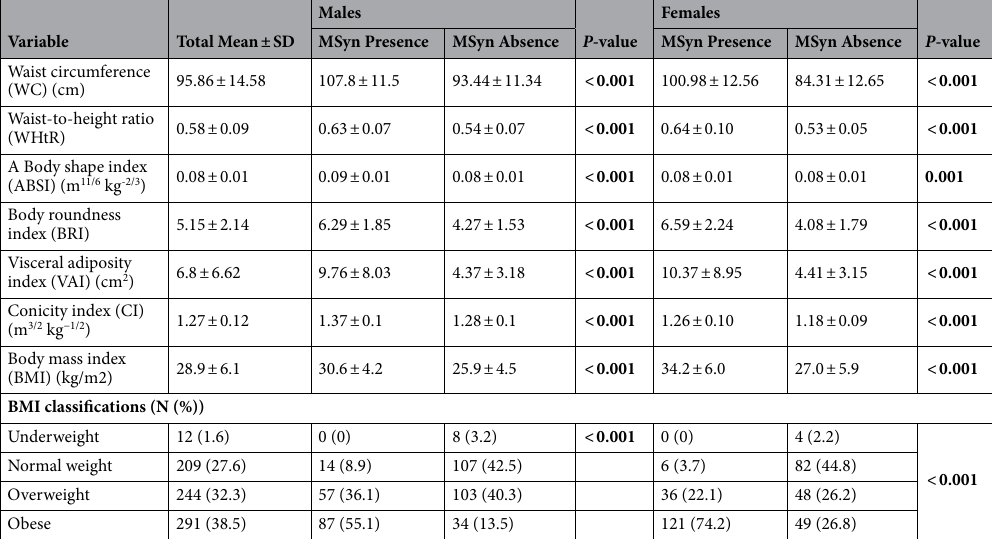
Table 3. Means and standard deviations (SD) for the seven anthropometric indices among study subjects, with and without MSyn, stratified by gender. Data are presented as Means ± SD for anthropometric indices, while presented as Numbers and Percentages (N (%)) for BMI classification. Independent-samples t-test was performed to compare the means of anthropometric indices, while Chi-square test was performed to test the differences in the BMI classification between subjects with or without MSyn within each gender group. MSyn Metabolic Syndrome. *P < 0.05 in the comparison between subjects with or without MSyn within the same gender group. Significant values are in